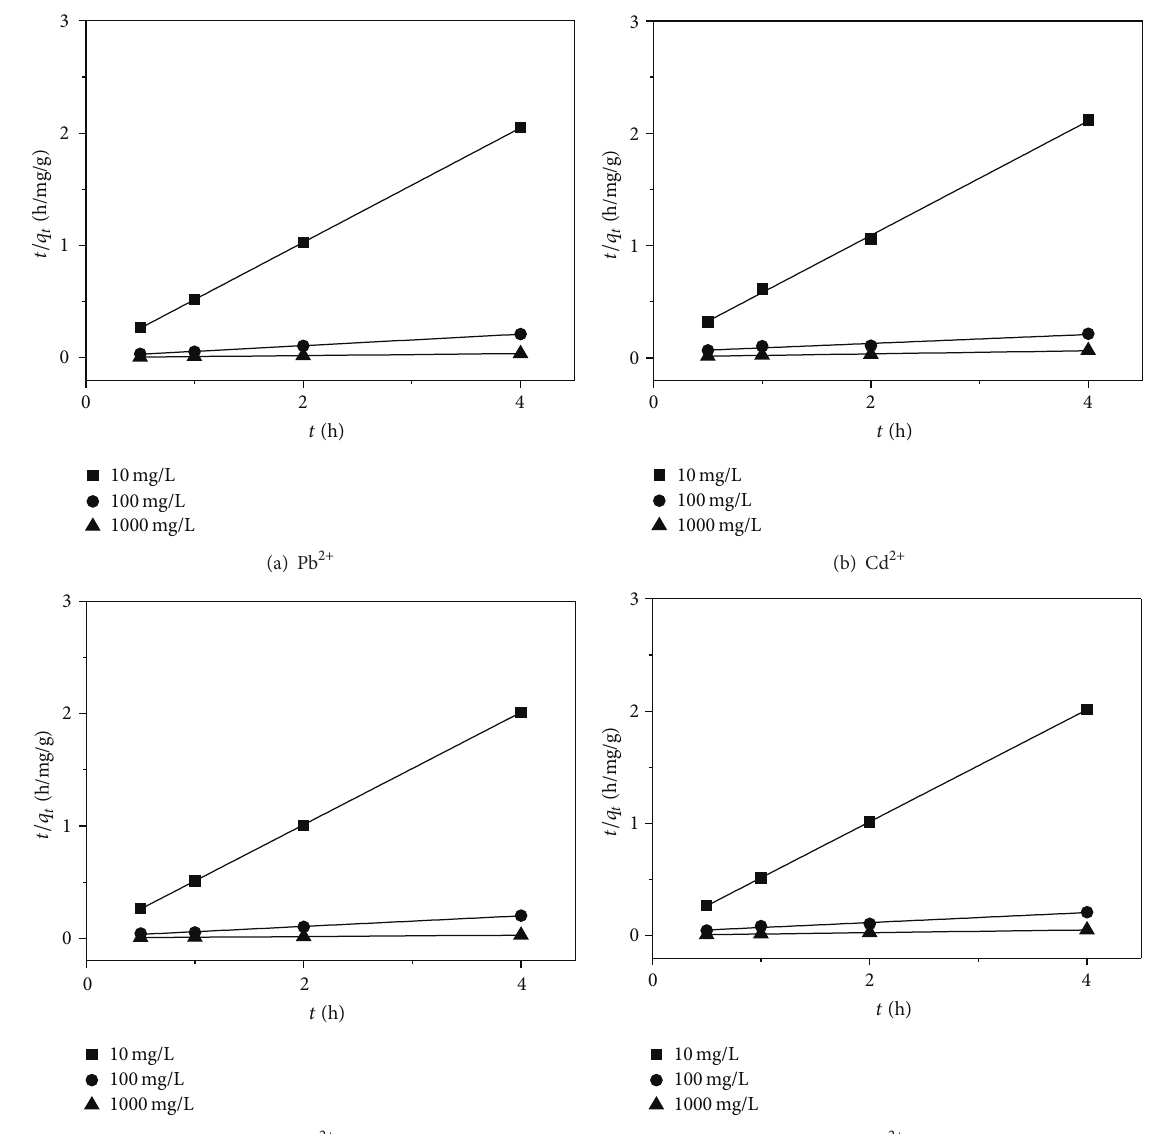
Figure 9: Pseudo-second-order kinetic model for adsorption of Pb 2+ and Cd 2+ by the HAp/chitosan hybrid fibers: (a) and (b) 10/90, (c) and (d) 20/80 HAp/chitosan hybrid fibers.